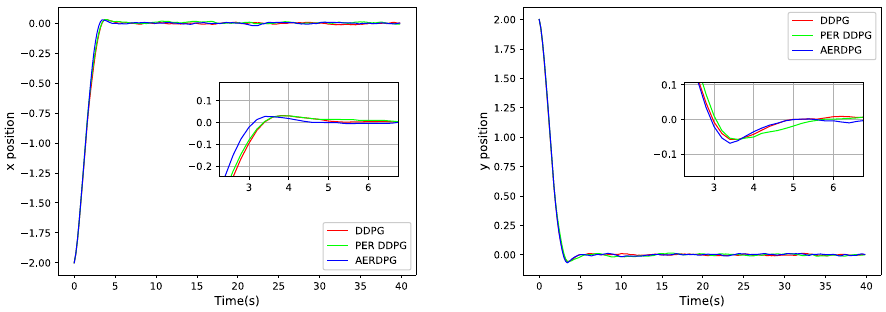
Figure 7. The AUV control effect for various target motion probabilities.